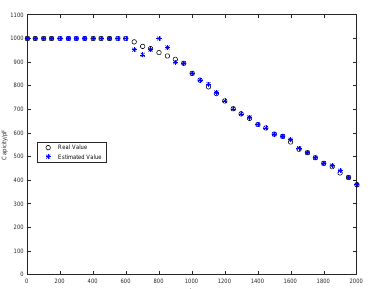
Figure 3. Real value vs. estimated value of STUKF for attenuation type fault.